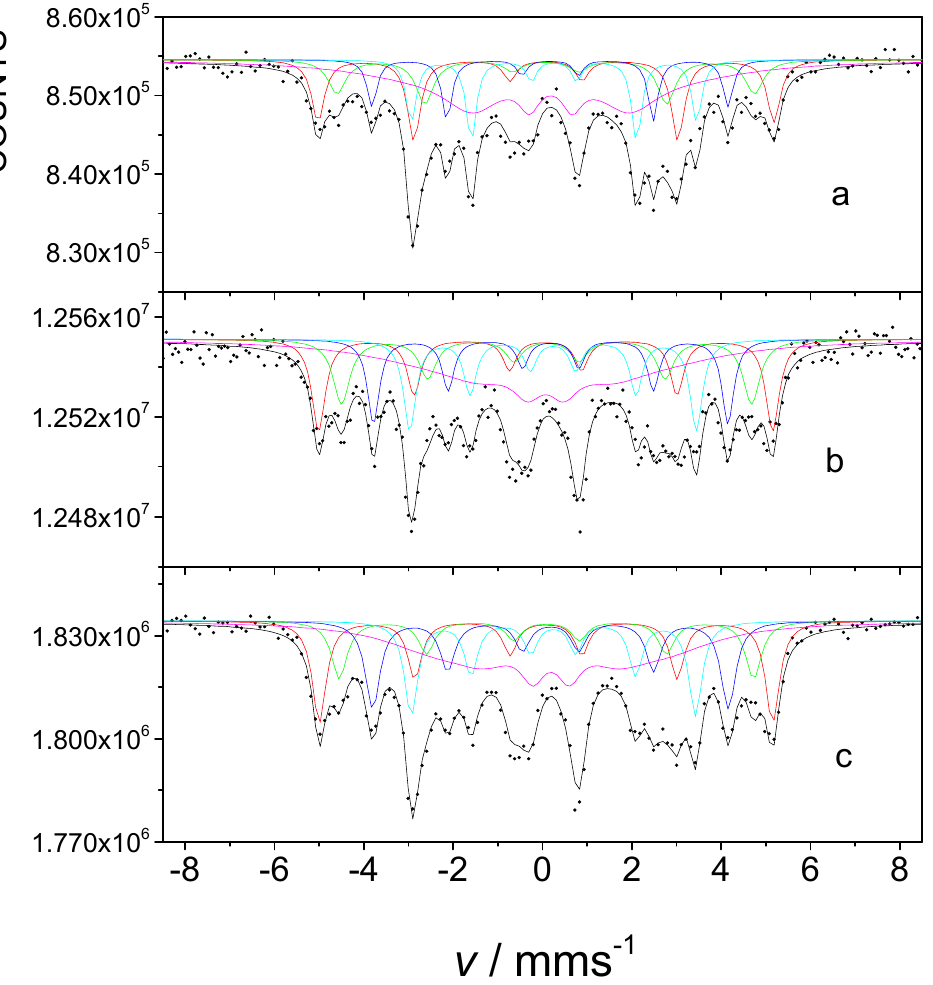
Figure 5 . Room temperature transmission 57 Fe Mössbauer spectra of FINEMET samples CK023 ( a ) non-irradiated and after their first irradiation by 160 MeV 132 Xe 28+ ions at a fluence of 10 13 ion cm − 2 from the air side ( b ) and from the wheel side ( c ).